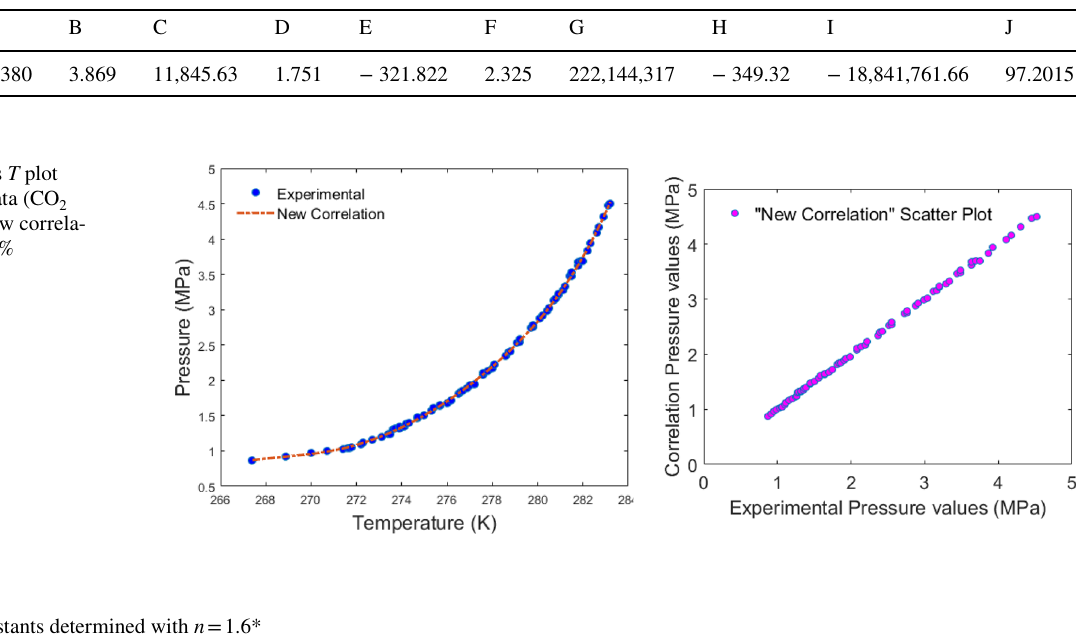
Table 12 The constants determined with n = 1.5*